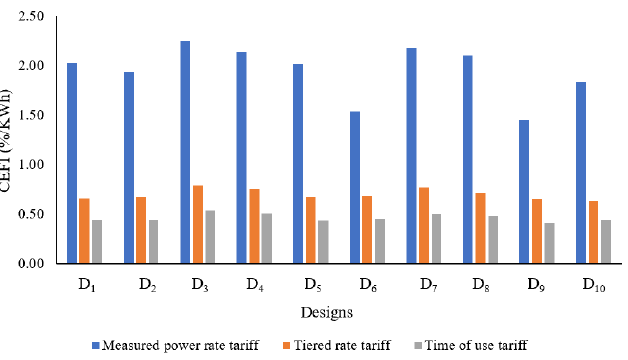
Figure 10. The CEFI values for the ten designs in the reference scenario and three